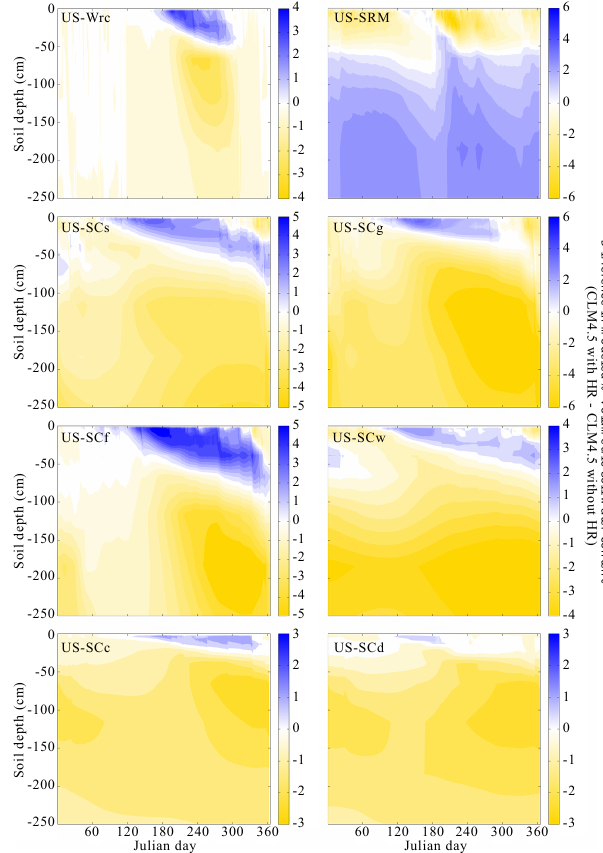
Figure 4. Modeled HR-induced change in volumetric soil moisture at the eight study sites. Results shown here are the averaged values for Julian days over the entire simulation